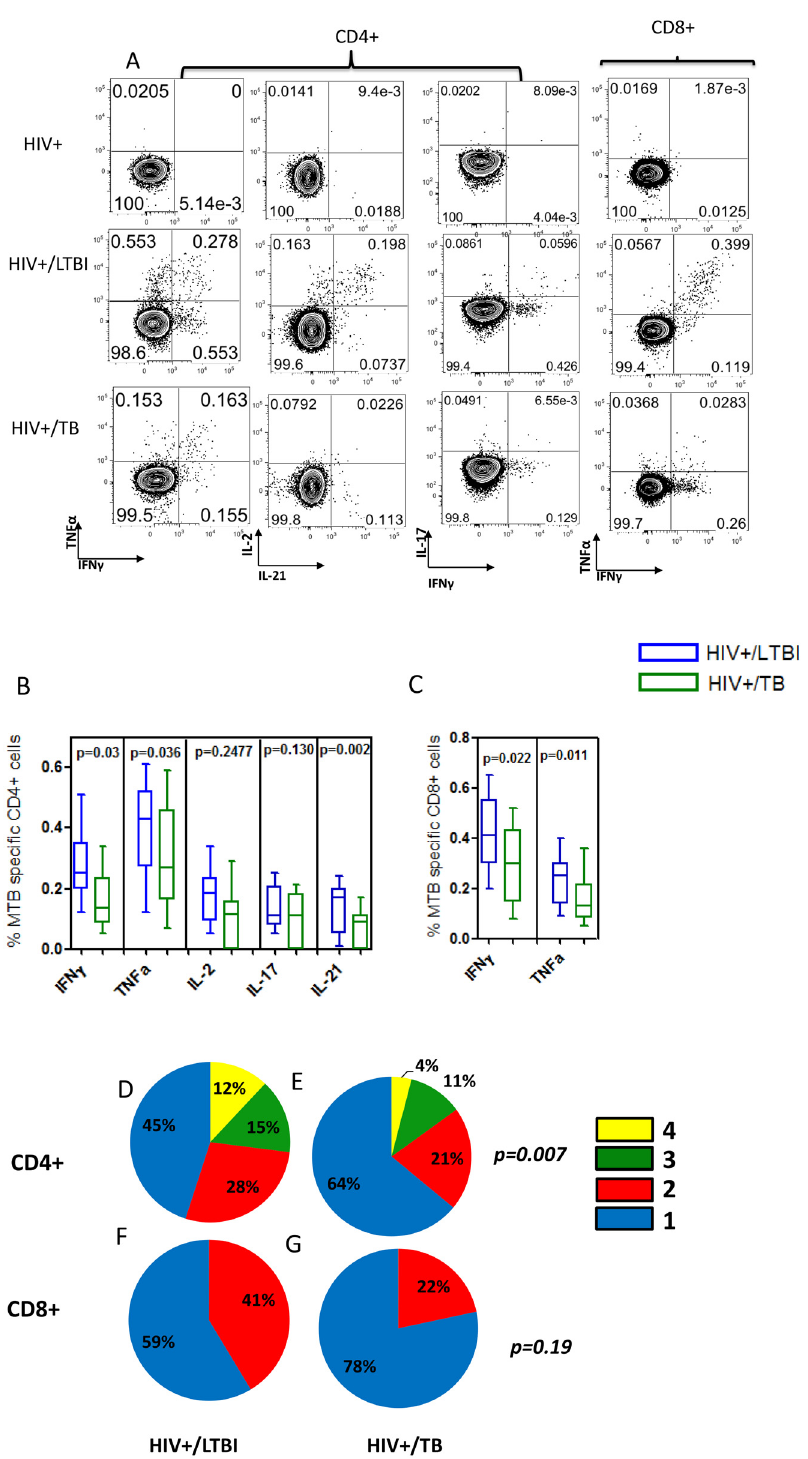
Fig 2. MTB-specific CD4+ and CD8+ T cell functionality is reduced in HIV infected individuals co- infected with latent Mycobacterium tuberculosis infection (LTBI) and active tuberculosis (TB) disease. (A) Representative flow cytometry plots showing cytokine IFN-gamma and TNF- α response for Mycobacterium tuberculosis (MTB) (CFP-10 and ESAT-6). Corresponding negative controls (no antigen) are the same as shown in Fig. 1B. (B) MTB-specific CD4+ release of IFN γ (p = 0.03), TNF α (p < 0.03) and IL-21